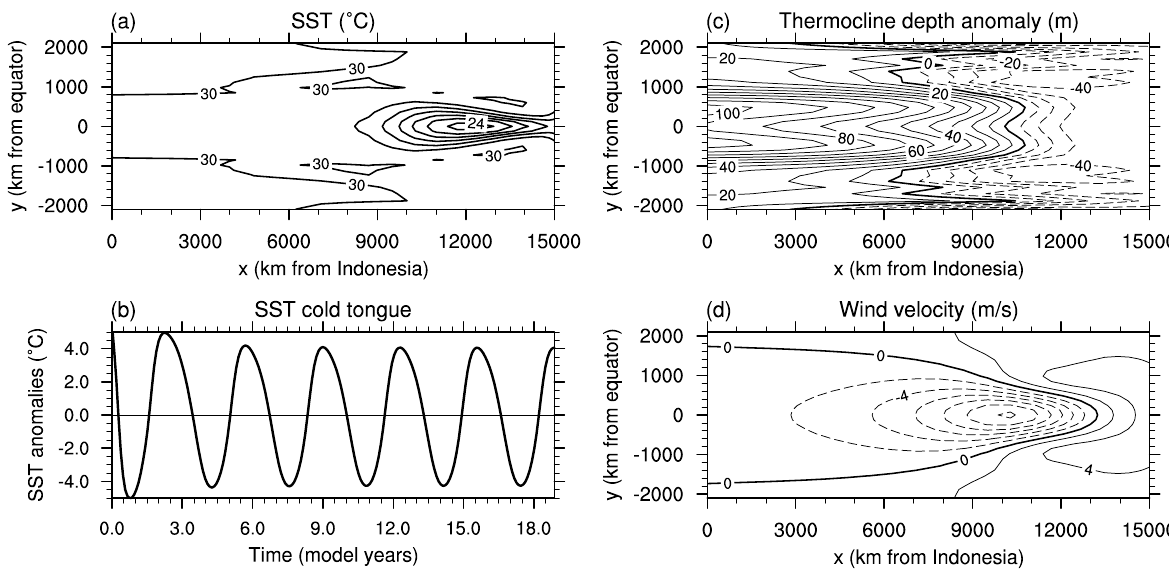
Fig. 2. Climatology and variability as simulated by the model under present-day conditions with standard parameter values, as indicated in Table 1. The radiation equilibrium temperature T 0 =30 ◦ C and the external wind-stress amplitude τ 0 = 0 . 01Pa. (a) Time-mean spatial SST distribution in ◦ C. Contour interval is 1 ◦ C. (b) SST anomalies (in ◦ C) in the cold tongue on the equator at x =12500km from Indonesia. (c) Time-mean thermocline depth anomaly h (in m). Contour interval is 10m. (d) Time-mean zonal wind velocity u a (in ms − 1 ). Contour interval is 2ms − 1 .